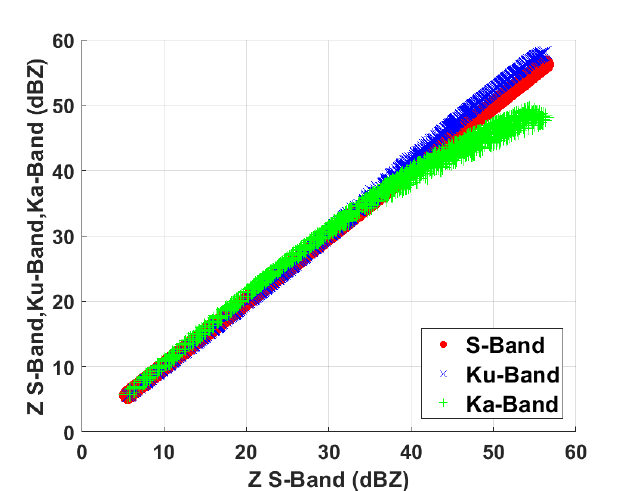
Figure 2. Relationship between reflectivities simulated at S, Ku, and Ka-band for raindrops using T-Matrix